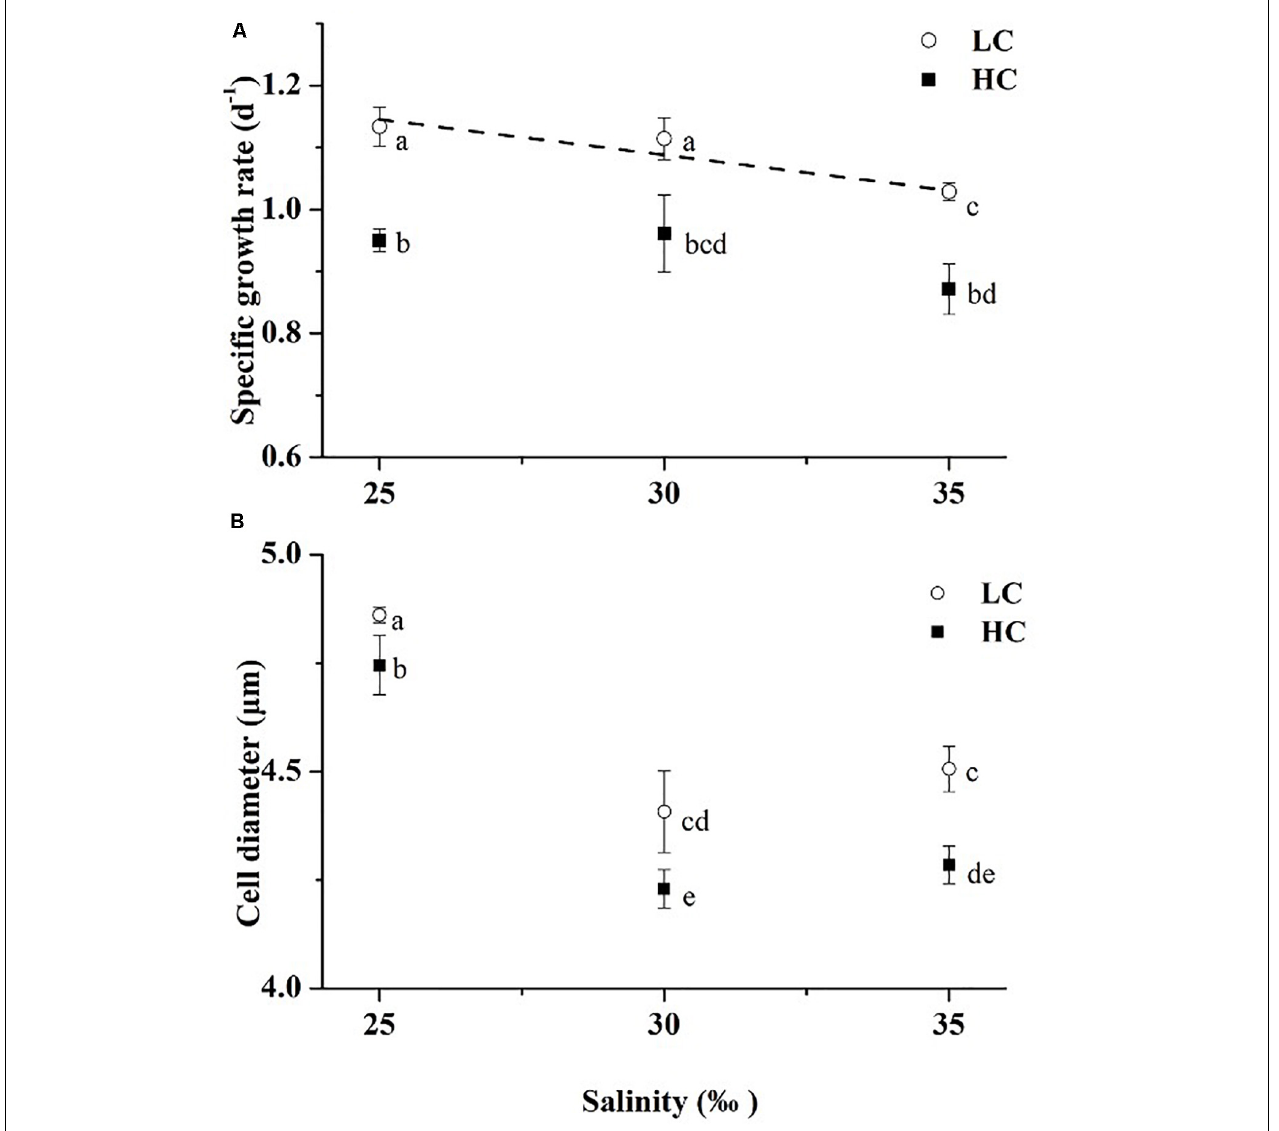
FIGURE 1 | Specific growth rates (A) and cell diameters (B) of Emiliania huxleyi at three salinities (LC, open circles; HC, solid squares). The dashed line is the linear regression result of the growth rates under LC ( y = -0.01142x + 1.43055, R 2 = 0.88). Lines in this and subsequent figures are only presented in cases where there were significant linear trends of parameters with salinity. Values are means ± SD of triplicate cultures. Symbols with different lowercase letters indicate significant differences ( p < 0.05) among different